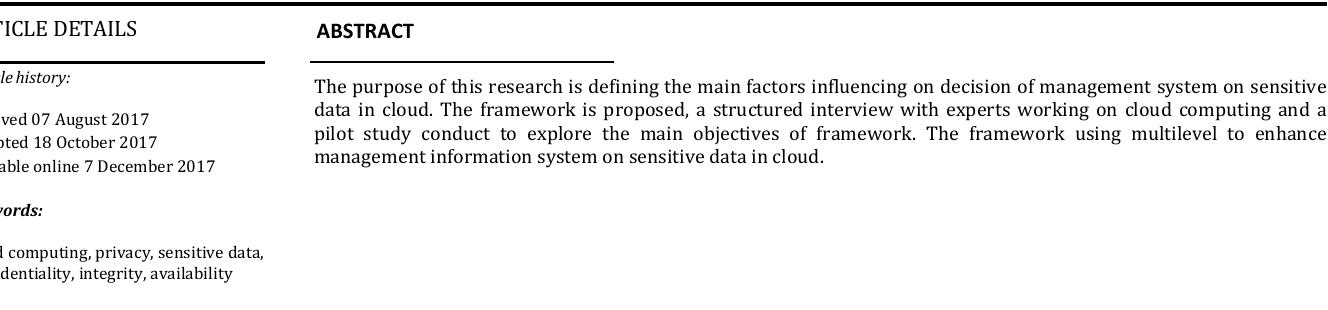
Figure 1: The proposed Framework (M2LF)